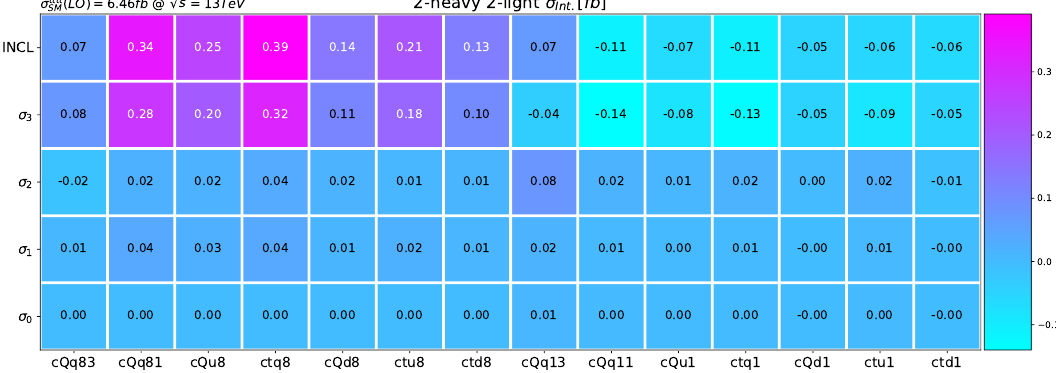
Figure 5 . Same as figure 4 but for the 2-heavy 2-light